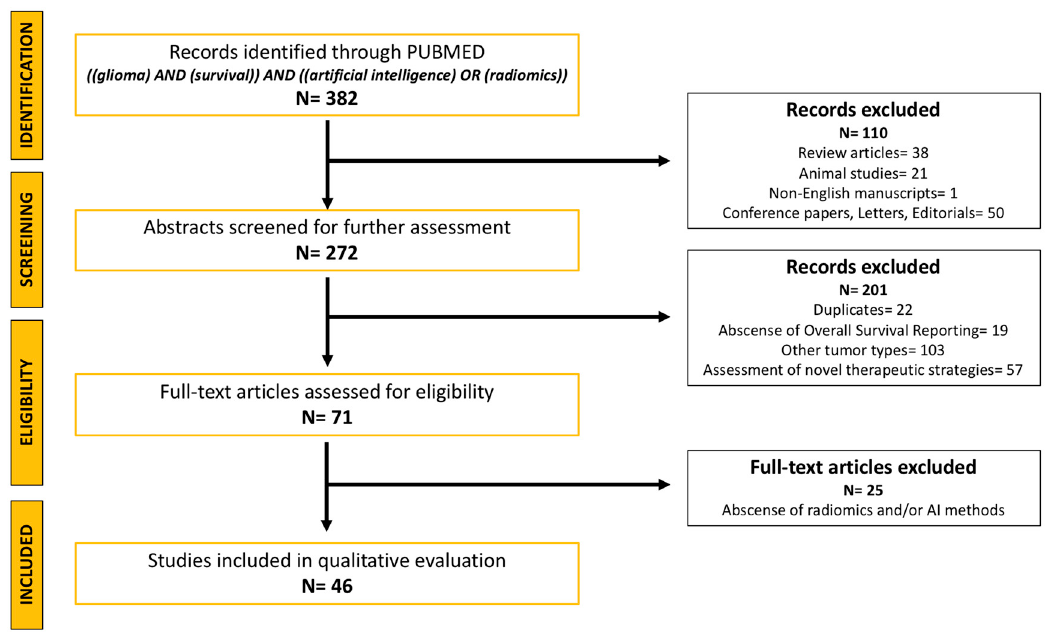
Figure 1. Flowchart depicting the identification, screening and inclusion of studies in the present Figure review.